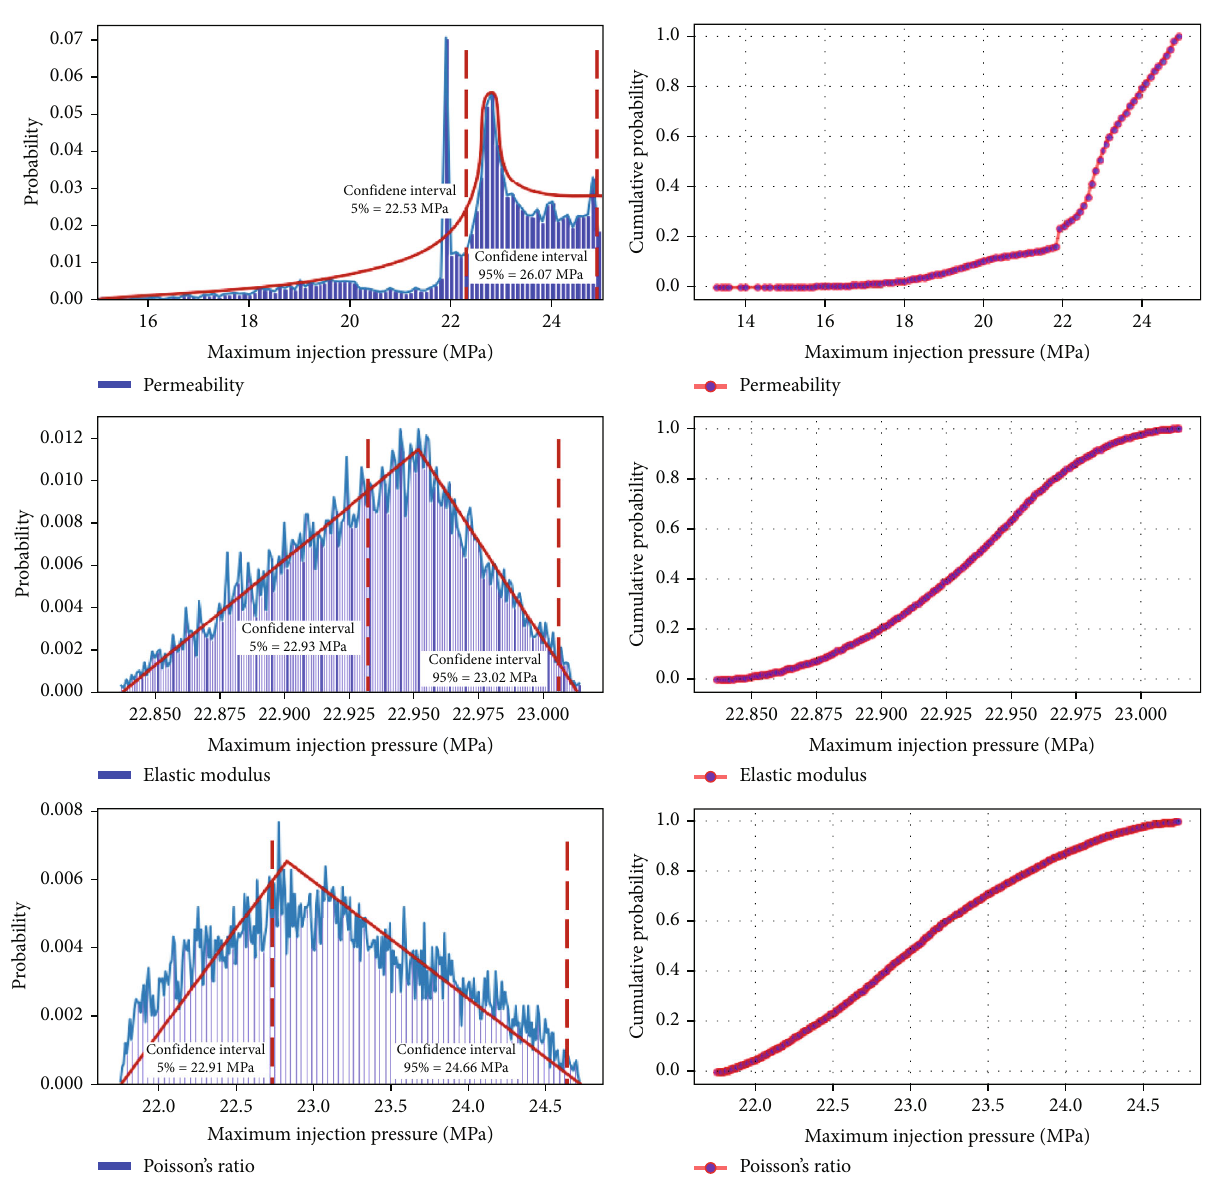
Figure 11: Probability distribution of K , E , and μ corresponding to the maximum injection